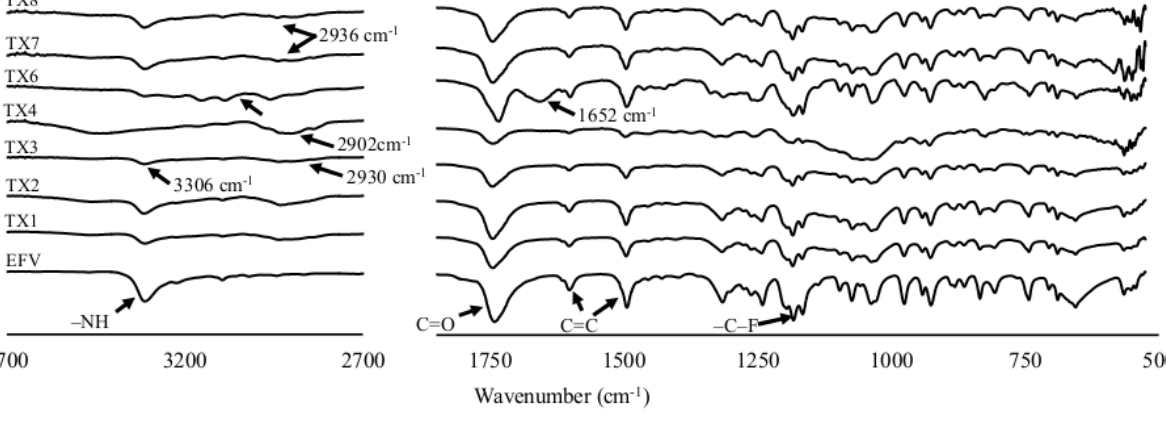
FIGURE 3 - Infrared spectra of EFV and processed samples. Efavirenz (EFV) respective group bands are marked with arrows. Subsequent arrows are marking: 2902 cm-1, 2930 cm-1 and 2936 cm-1 are relative to CH and CH2 bands; 1652 cm-1 associated with the pyrrolic ring of the